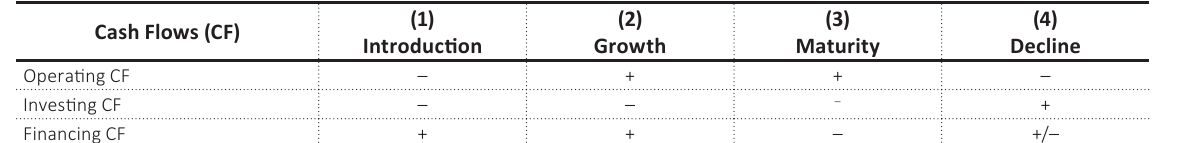
Table 1. Firm life cycle